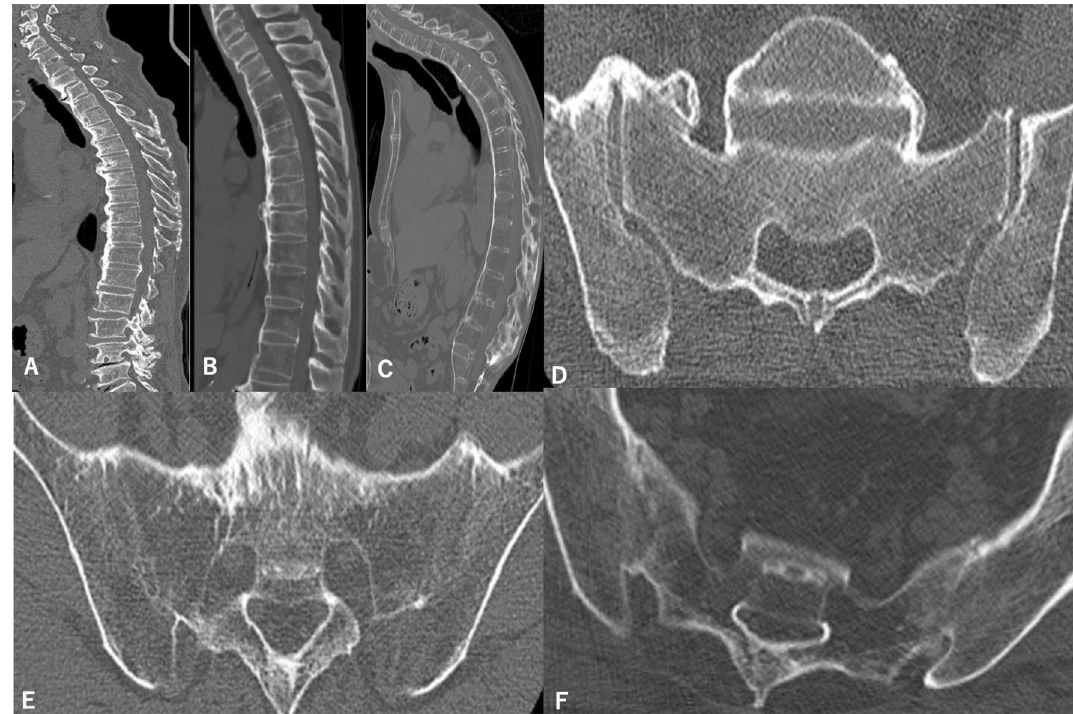
Figure 2. CT images of the case presentation. ( A ) Sagittal CT image of the whole spine shows 70–100% candle- wax-type in a 70-year-old male patient with DISH. ( B ) Sagittal CT image of the whole spine shows 0–30% candle-wax-type in an 82-year-old male patient with DISH. ( C ) Sagittal CT image of the whole spine shows 0–30% candle-wax-type in a 54-year-old male patient with AS. ( D ) Axial CT image of SIJ shows anterior bony bridging of the right side and no joint fusion in a 78-year-old male patient with DISH. ( E ) Axial CT image of the SIJ shows complete joint fusion in a 75-year-old male patient with DISH. ( F ) Axial CT image of the SIJ shows complete joint fusion in a 63-year-old male patient with